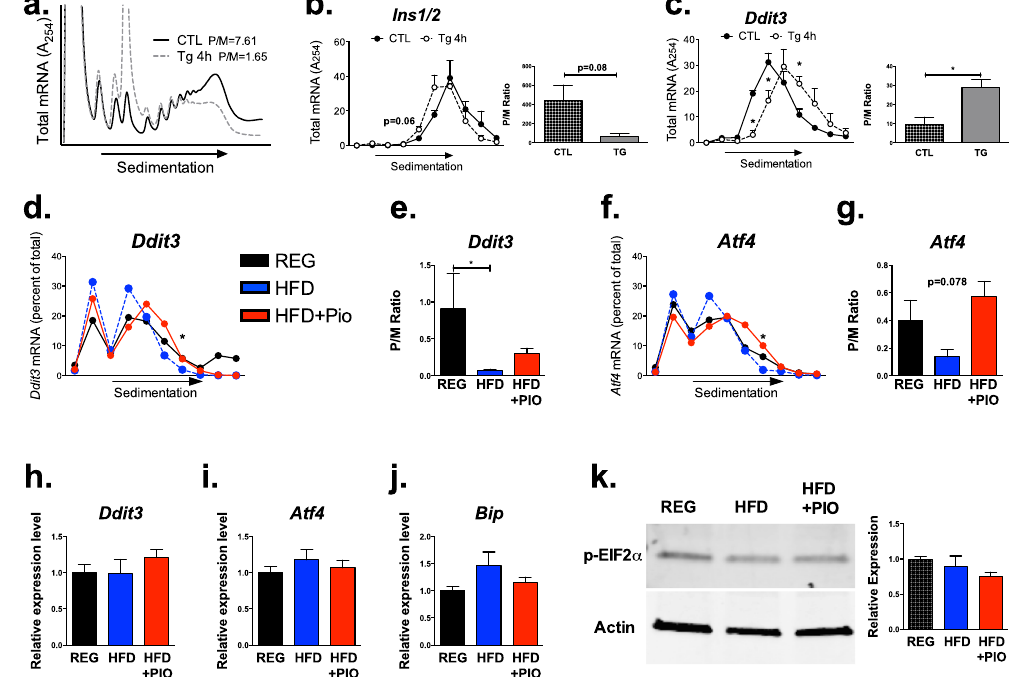
Figure 2. HFD-induced reductions in mRNA translation are not caused by ER Stress. ( a – c ) MIN-6 β cells were treated with thapsigargin (Tg) for 4 hours as a positive control for ER stress induction (n = 3 per group). ( a ) Representative global PRPs. For each fraction, transcript expression for ( b ) Ins1/2 and ( c ) Ddit3 were analyzed. ( d ) Composite curves representing average Ddit3 transcript expression in PRP fractions from islets of mice treated with regular chow (REG), 42% high fat diet (HFD) or HFD in combination with Pioglitazone (HFD + PIO). ( e ) P/M ratios for Ddit3 transcripts in each diet treatment group. ( f ) Average ATF4 transcript expression in PRP fractions from islets of mice in each diet group. ( g ) P/M ratios for ATF4 transcripts in each diet treatment group. ( h – j ) qRT-PCR analysis of total RNA inputs for genes associated with ER stress signaling, including Ddit3, Atf4, and Bip .( k ) Representative immunoblot and quantification of phosphorylated eukaryotic translation initiation factor 2 α (p-eIF2 α ) expression among diet groups. n = 3–5; * p <